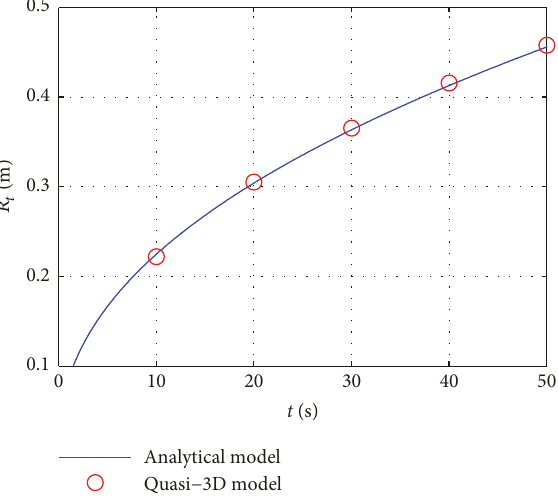
Figure 12: Variations of the pumping rate with time in Case 2.